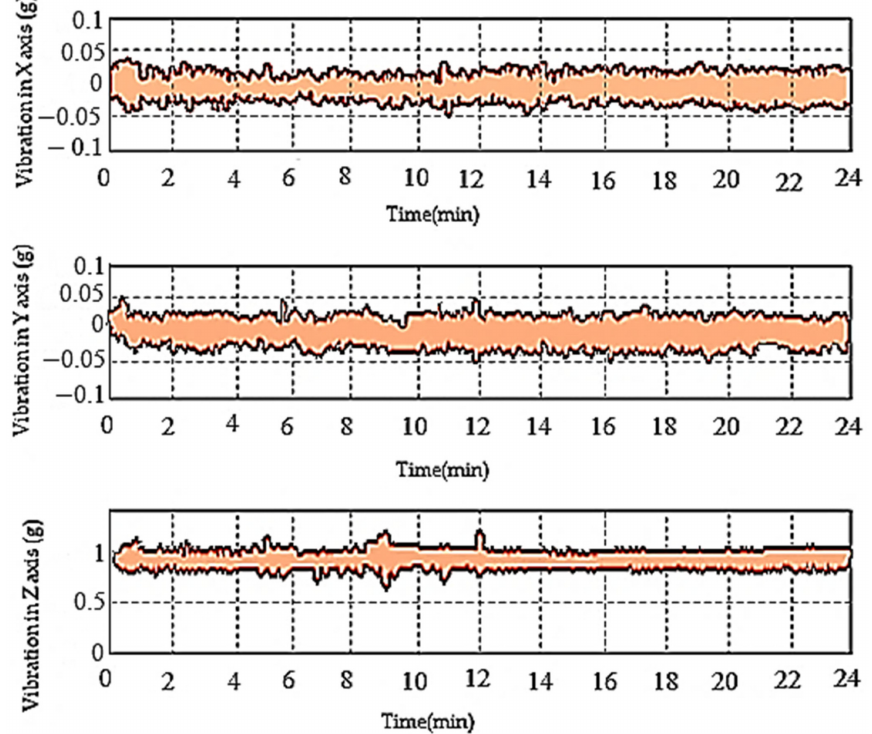
Figure 12. The vibration of MUAV during hover